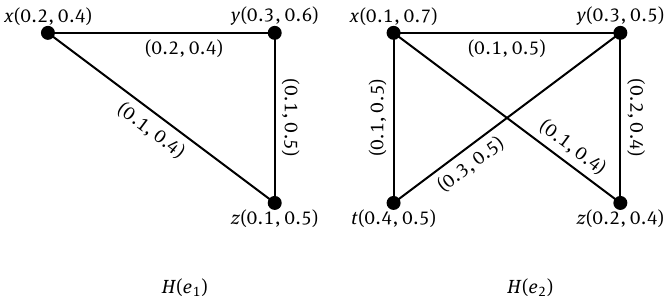
Figure 3: Complete interval-valued fuzzy soft graph (cid:101)